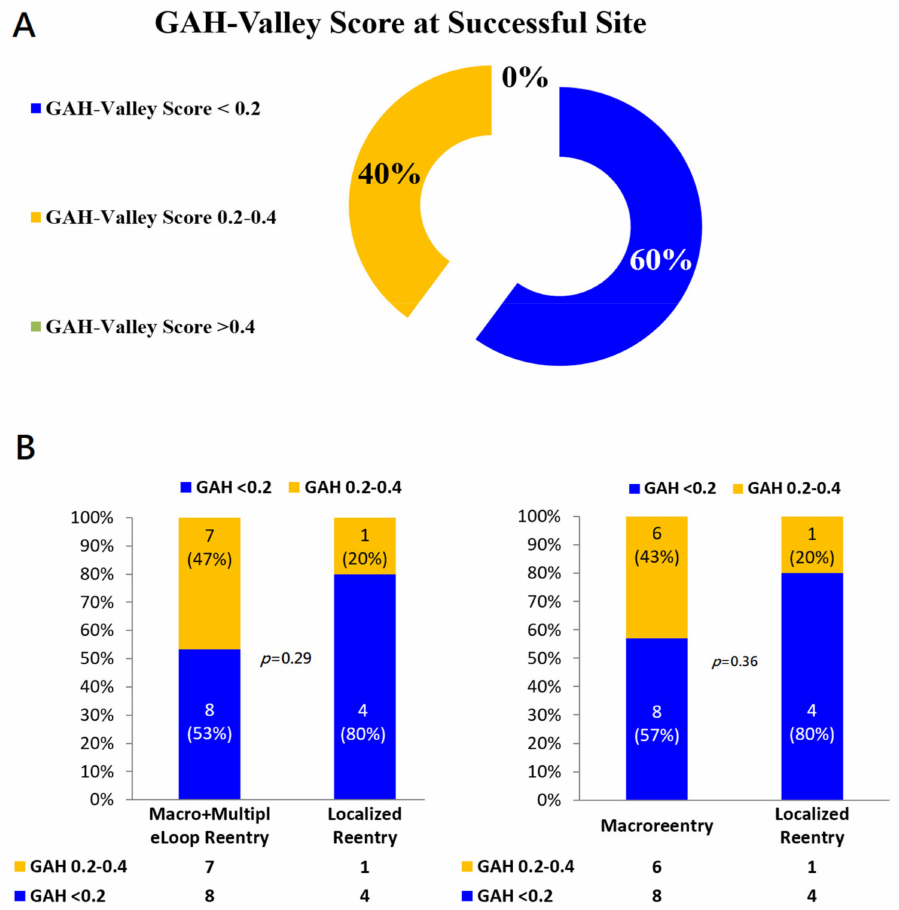
Figure 4. ( A ) GAH-Valley Score at the Successful Site. ( B ) Distributions of GAH-Scores in different types of Reentry aAFLs. In the localized reentry, the highlighted area of GAH-Valley scores < 0.2 significantly matched with the successful ablation sites, compared with both macro- and multiple-loop reentry aAFLs (Left). Likewise if excluding the multiple-loop reentry (Right). Right panel shows the reentry circuit in the LA anterior wall between the left atrial appendage (LAA) and aortic groove. Left panel shows that in SKYLINE, a GAH-Valley with a score of <0.2 was identified. Middle panel shows the very beginning of the valley highlighted two areas: a critical slow conduction between LAA and aortic groove (solid bold line with arrow), and a line of block in LSPV (dashed line with round head). Ablation on the slow conduction terminated the aAFL. Left panel shows the SKYLINE pattern with 2 GAH-Valleys. A: The deepest valley with a GAH-score < 0.2 (red hollow arrow) highlighting one area (site 1), representing